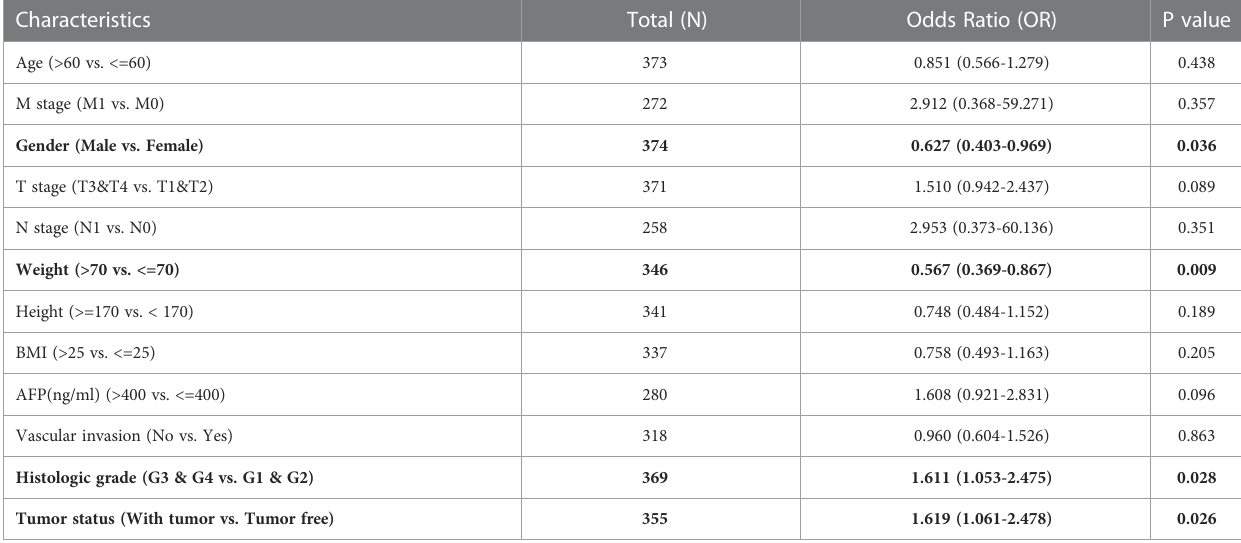
TABLE 1 Association between RAB22A expression and clinicopathologic parameters by Logistic regression. Characteristics Total (N) Odds Ratio (OR)